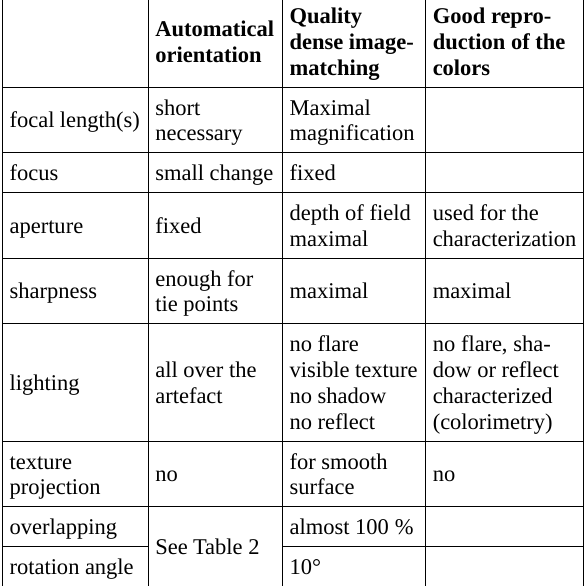
Table 1: Some parameters relative to the constraints